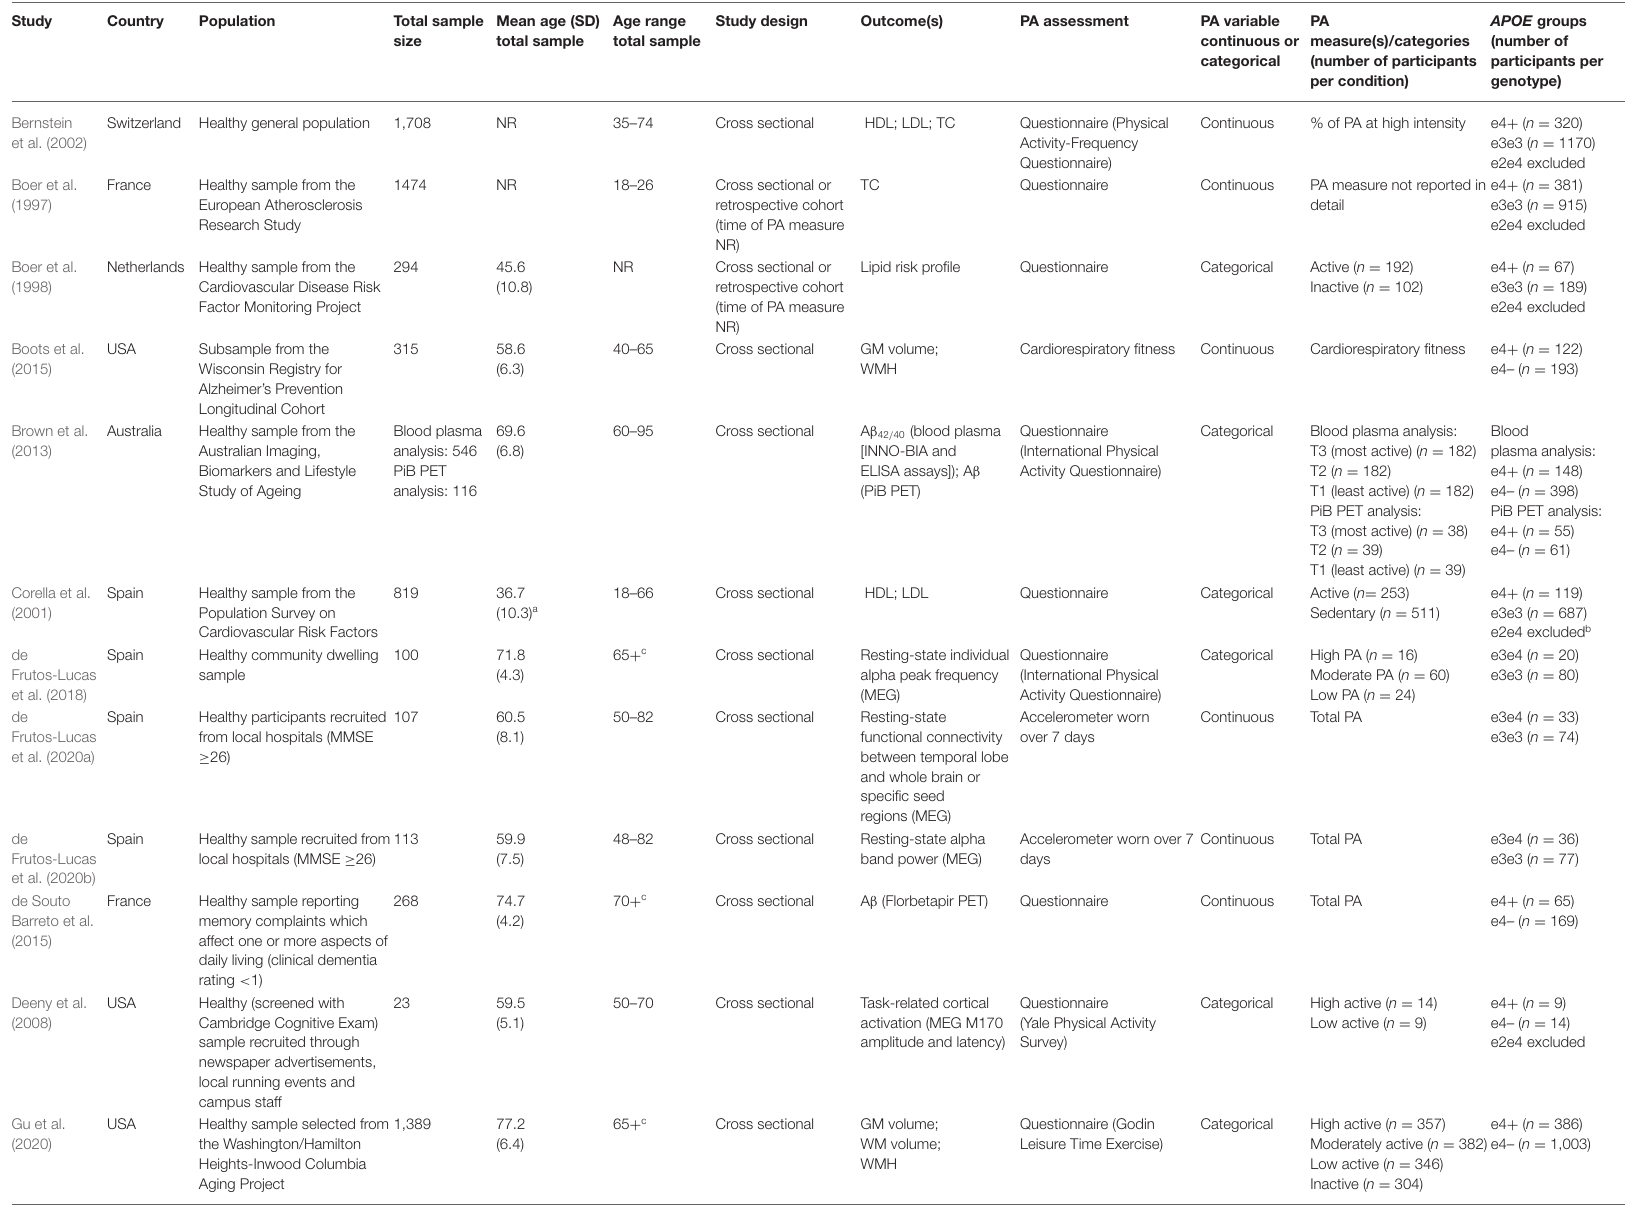
TABLE 1 | Study characteristics for all included studies assessing APOE differences in the association between physical activity and all outcomes. Study